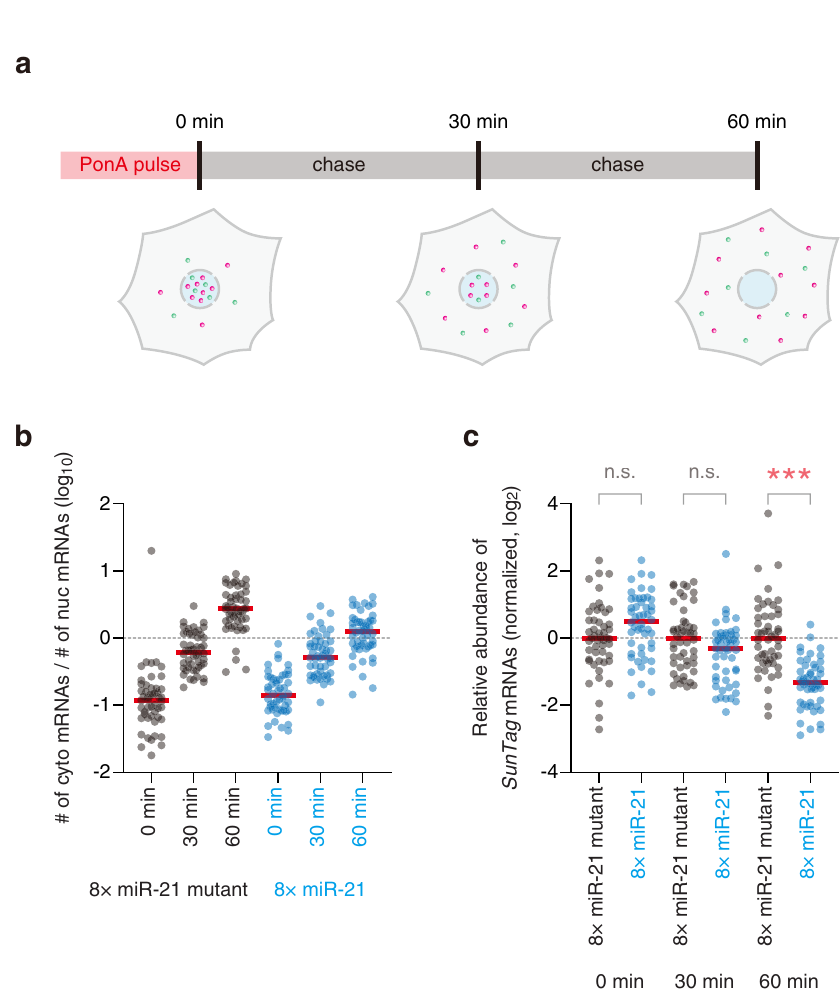
Fig. 6 Spatiotemporal analysis of mRNA decay by single-mRNA imaging. a Schematic of spatiotemporal analysis of mRNA decay by single-mRNA imaging. In pulse-chase experiments, smFISH was performed to visualize mRNA decay at single-mRNA resolution. Green and magenta spots represent SunTag and Fluc mRNAs, respectively. b Transport of reporter mRNAs from the nucleus to the cytoplasm. In pulse-chase experiments, reporter mRNAs were labeled by smFISH. The ratios of the number of cytoplasmic mRNAs to that of nuclear mRNAs are shown. Each circle represents a single cell ( n = 50 for each condition), while red lines represent the medians. cyto, cytoplasmic. nuc, nuclear. c Time-course analysis of mRNA decay by single-mRNA imaging. Images were analyzed using CellPro fi ler and FISH-quant. Then, mRNA stability (the relative abundance of SunTag mRNAs to Fluc mRNAs) was calculated as described in Supplementary Fig. 2 (see also Methods), followed by normalization to the value of the negative control at each time point. Each circle represents a single cell ( n = 50 for each condition), while red lines represent the medians. The results of Dunn ’ s multiple comparisons test are shown. *** and n.s. represent p < 0.001 and not signi fi cant ( p > 0.05), respectively. p -values were 0.24 (0 min), 0.11 (30 min), and 6.4 × 10 − 10 (60 min). Note that time-course data of RISC-binding, translational repression, and mRNA decay were analyzed using exactly the same statistical test (Dunn ’ s multiple comparisons test). Source data are provided as a Source Data fi